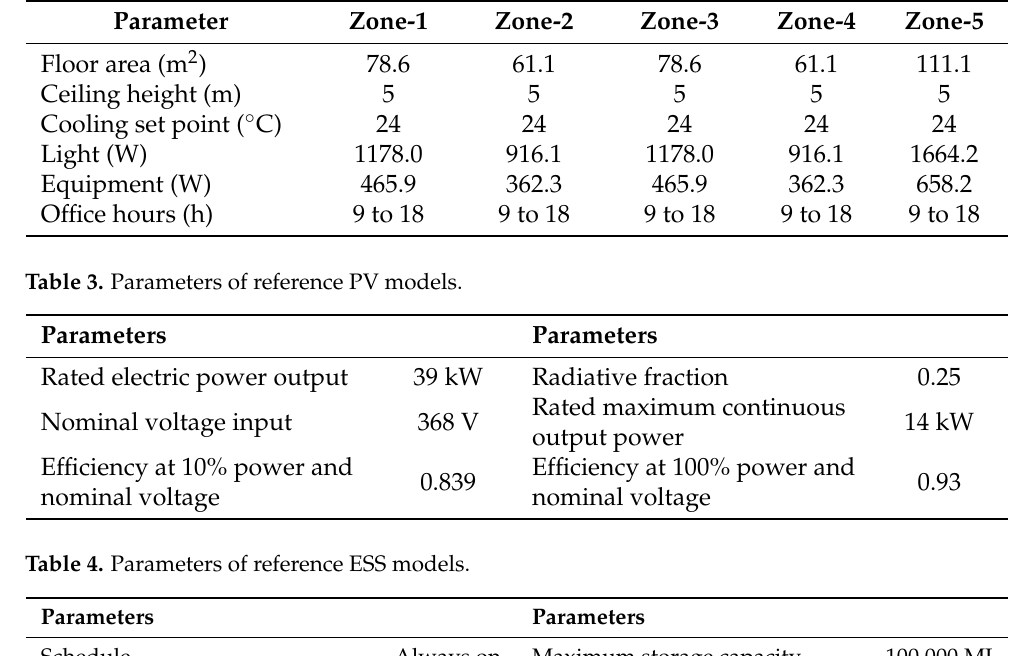
Table 2. Parameters of the reference building models.